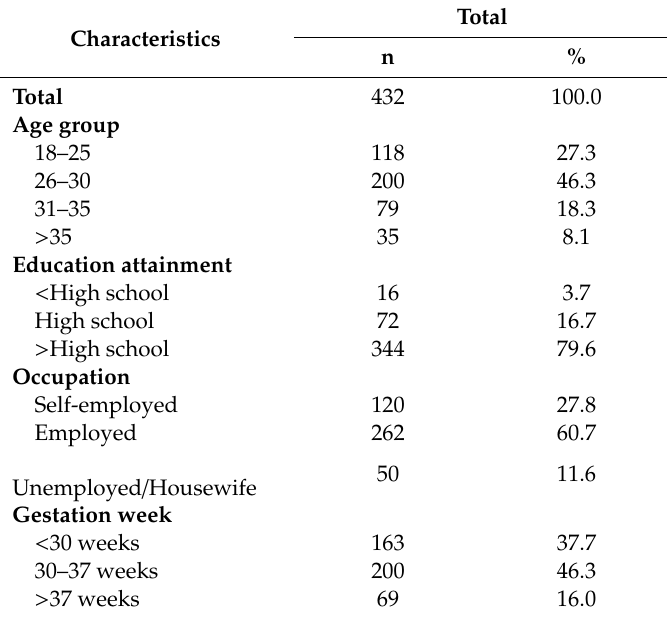
Table 1. Demographic characteristics of pregnant